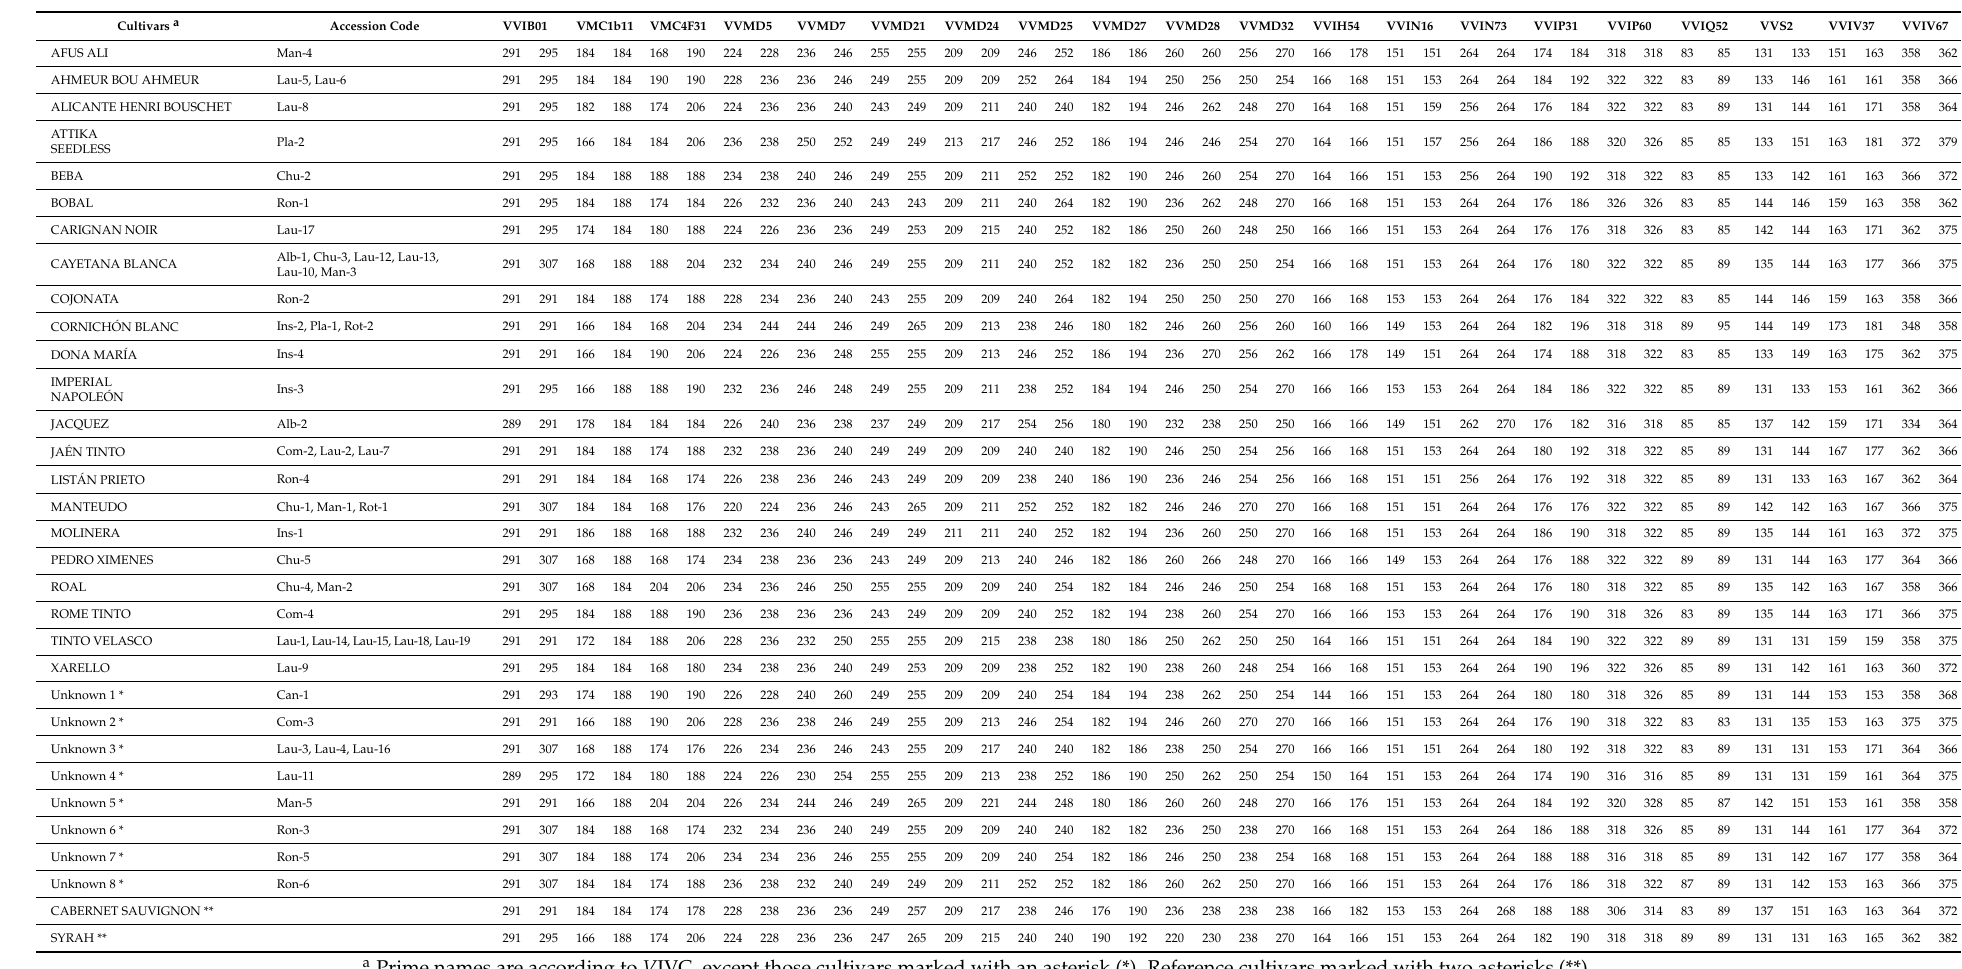
Table 1. Thirty genotypes obtained for the 49 analyzed accessions at 20 microsatellite loci. Allele sizes are given in base